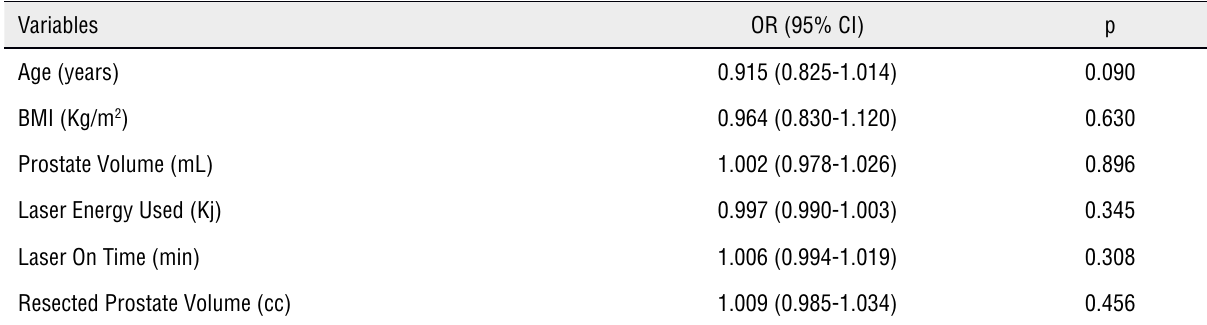
Supplementary Table 1.3 - Results from multivariable logistic regression analysis assessing for risk factors for long- term SUI in HoLEP